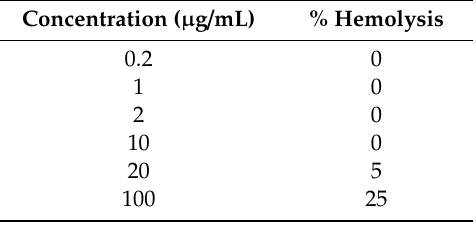
Table 3. Hemolytic activity of indolicidin peptide at various concentrations.